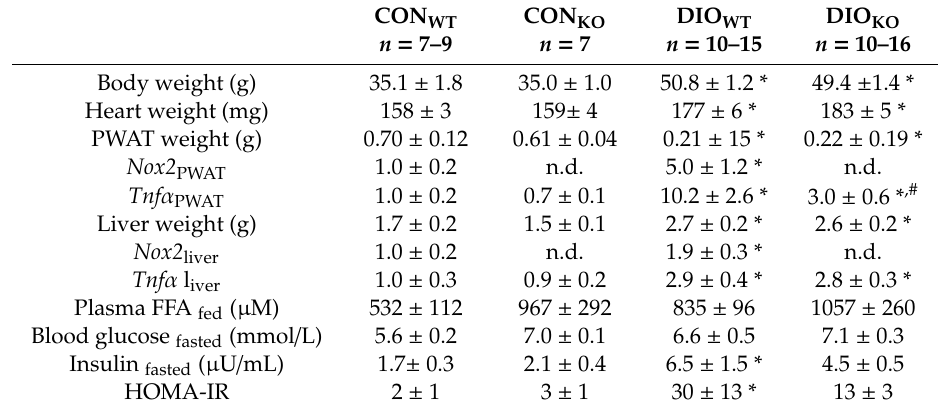
Table 1. Animal characteristics of wild type (WT) and global NOX2 knock-out (KO), control mice (CON), and diet-induced obese mice (DIO) given an obesogenic diet for 28 weeks.